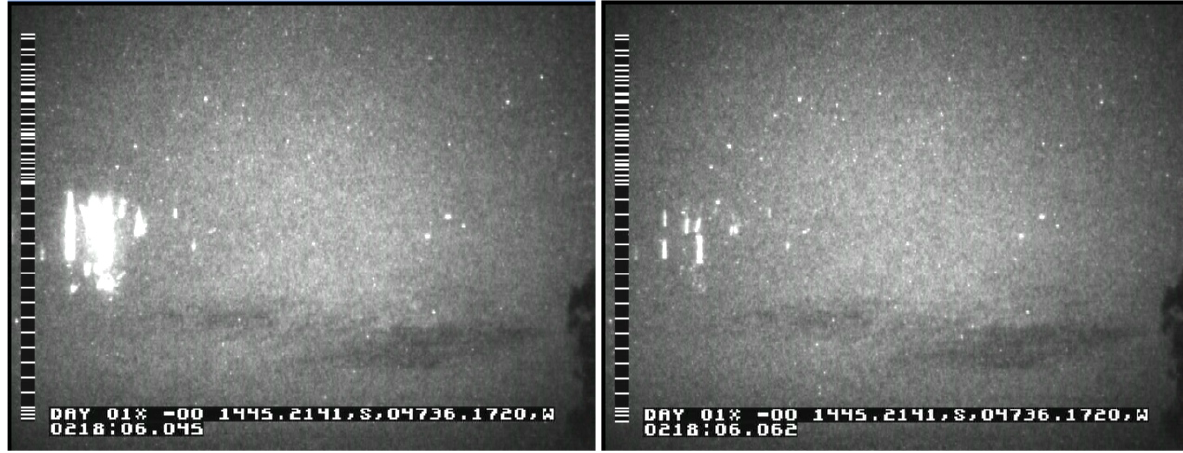
Fig. 6. Group of columns sprites with 33ms duration produced by the third thunderstorm locate in Goi´as State.